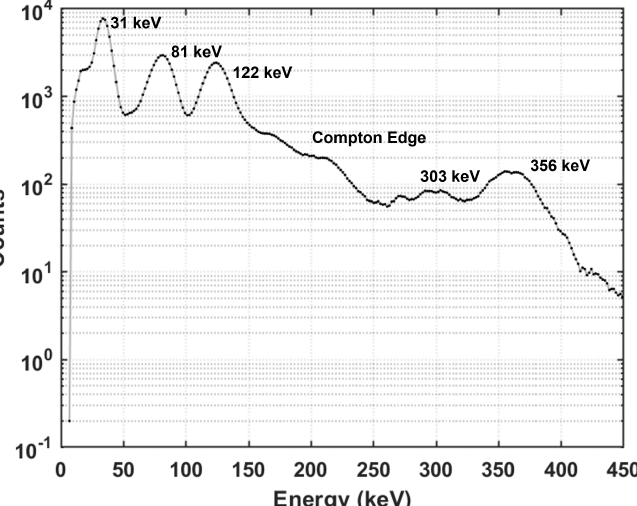
Figure 6. Gamma-ray spectrum resulting from the irradiation of the 2.5 mm 57 Co and 133 Ba colli- mated